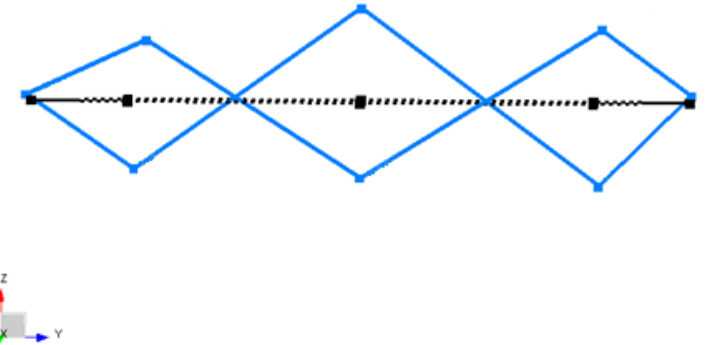
Figure 11. Second mode shape obtained from LMS Test Lab software for a Type-1 coil sample.